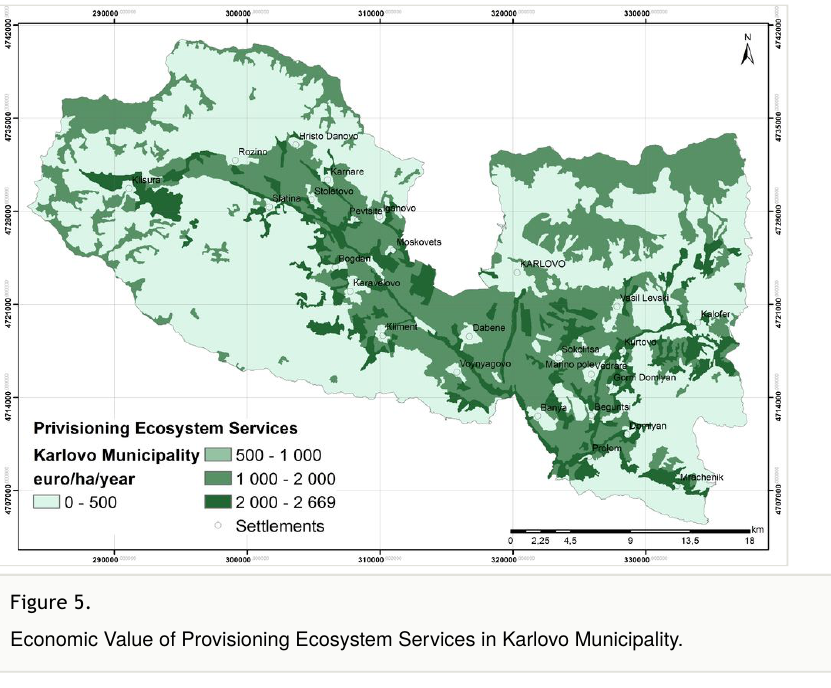
Figure 5. Economic Value of Provisioning Ecosystem Services in Karlovo Municipality.